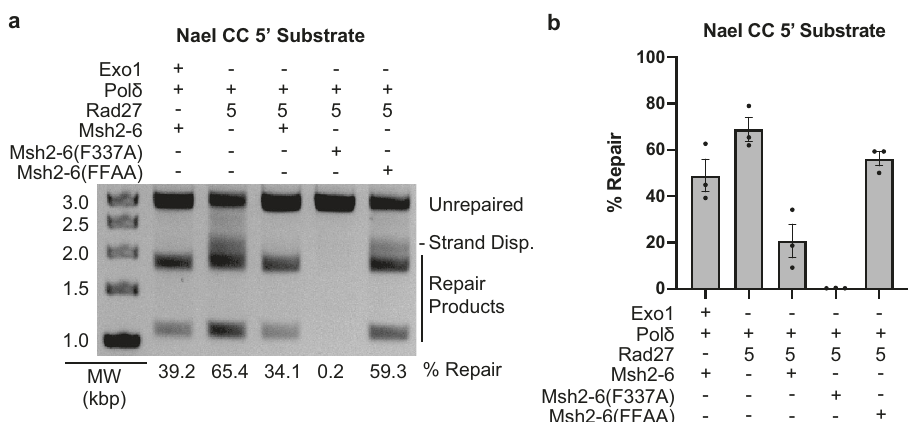
Fig. 4 Effect of substituting wild-type Msh2-Msh6 for two different mutant Msh2-Msh6 complexes in a 5 ′ nick-directed Rad27-dependent MMR. a Representative assay of 5 ′ nick-directed repair of the CC substrate in which different proteins were omitted or substituted as indicated. All reactions also contain PCNA, RFC- Δ 1N, and RPA. Other than Rad27, the amounts of all proteins used in the assays are as listed in the “ Methods ” section. MW, molecular weight markers. The percent repair corresponds to the fraction of all DNA in each individual lane susceptible to PstI cleavage, including those labeled “ strand displacement ” and “ repair products ” . b The amount of repair for the reactions was quanti fi ed. Three independent experiments were performed and the average amount of repair observed is reported. Error bars represent the standard error of the mean, and individual values from the different experiments are indicated by the dots on each histogram bar. Bar graph was constructed in GraphPad Prism software.